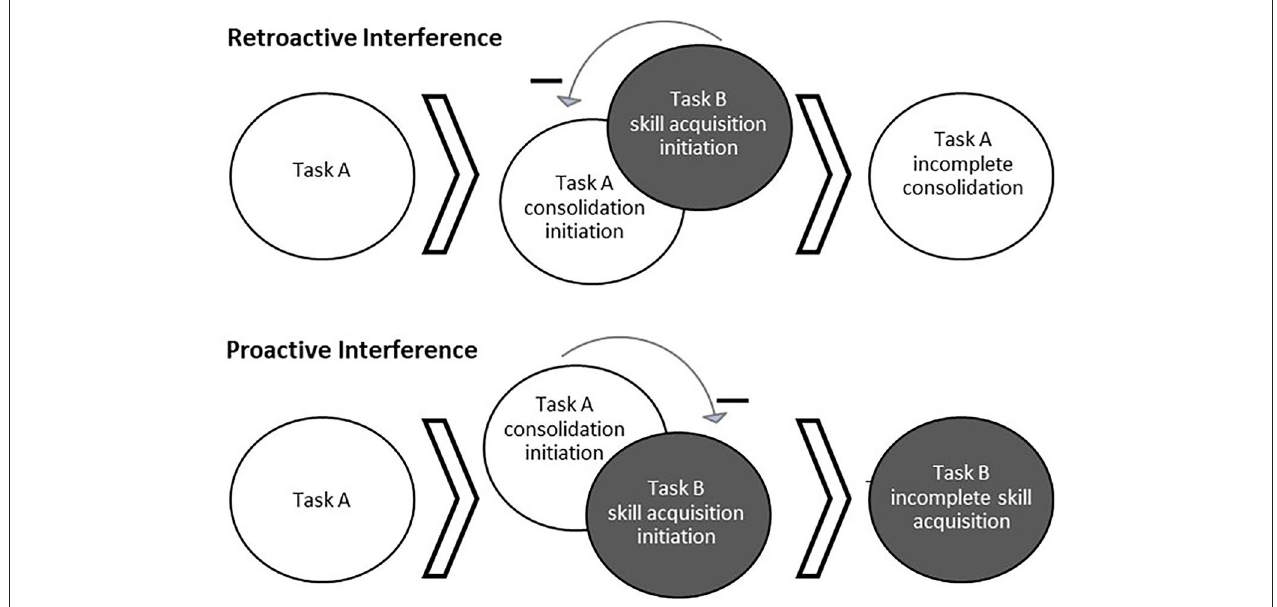
FIGURE 1 | Behaviorally-induced retroactive and proactive interference. Interference occurs when the processes for learning multiple tasks interact and cause a detriment to the consolidation or acquisition of one of the tasks. Top: Acquisition of a second task (Task B) while a first task (Task A) is still undergoing consolidation can result in interference of Task A consolidation, known as retroactive interference. Bottom: Alternatively, ongoing consolidation of a first task (Task A) can interfere with the acquisition of a second task (Task B), known as proactive